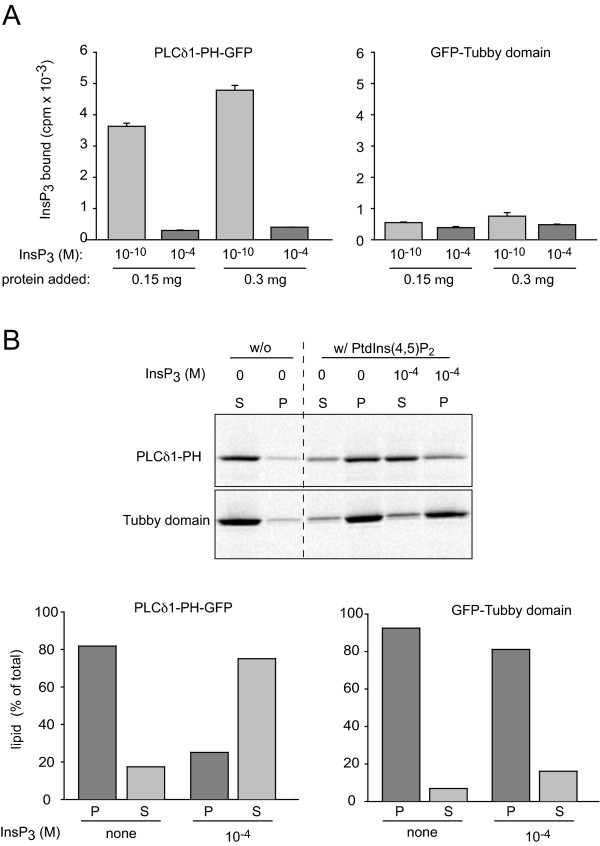
InsP3 and PtdIns(4,5)P2 binding of recombinant PLCδ1PH-GFP and GFP-Tubby-domains. Panel A: InsP3 binding assays were performed at room temperature using [3H]-Ins(1,4,5)P3 in the presence or absence of the indicated concentrations of unlabeled InsP3 as detailed under "Experimental Procedures". Means ± range of 2 experiments performed in duplicate are shown. Panel B shows the binding of recombinant proteins to lipid vesicles containing phosphatidyletanolamine in the absence or presence of PtdIns(4,5)P2 and InsP3. Vesicles were pelleted with ultracentrifugation and ''S'' and ''P'' represent the soluble (unbound) and pellet-associated (bound) GFP fusion protein, respectively, analyzed by a PhosphorImager after SDS-PAGE. The result of one of two experiments with identical results is shown. Note the negligible InsP3 yet very good PtdIns(4,5)P2 binding of the Tubby domain. The latter shows only a minor sensitivity to the presence of InsP3 in contrast to PLCδ1PH-GFP.